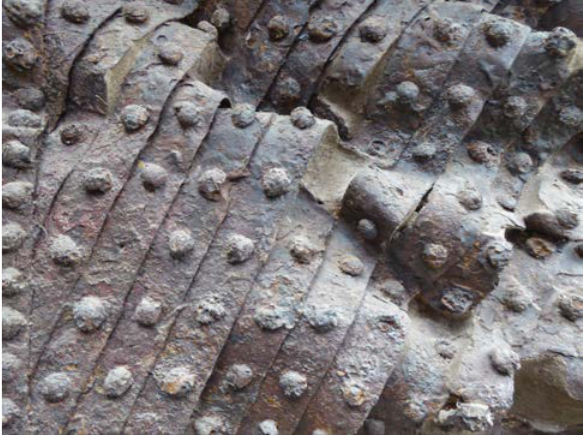
Figure 5. Detail, from the left side, of the external